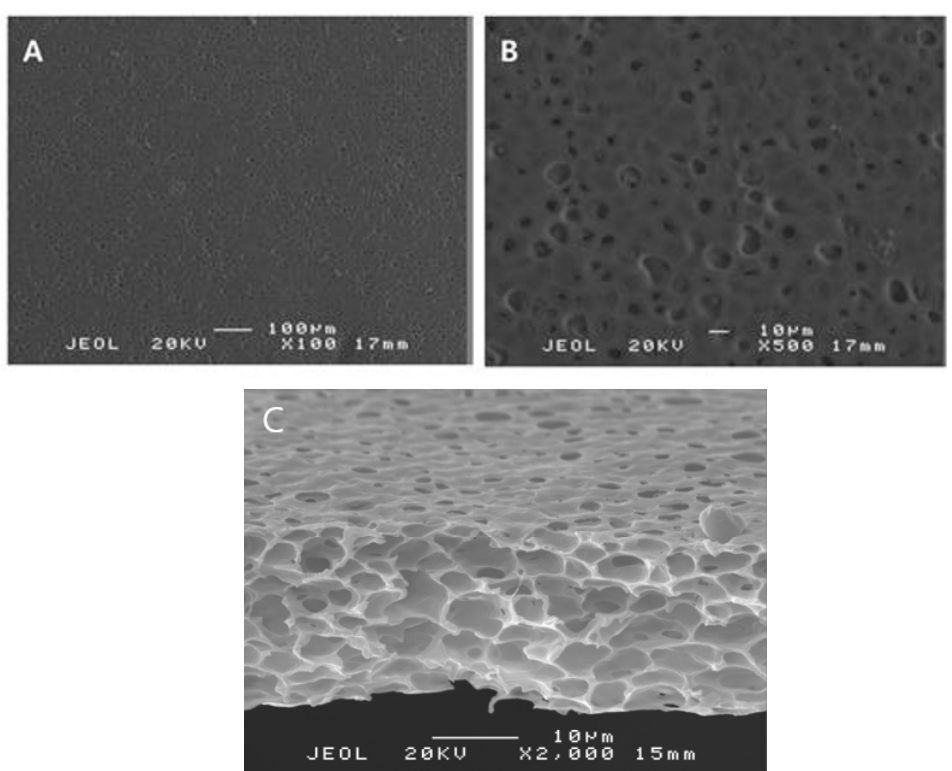
Figure 3. Scanning electron microscope image of a porous polylactide film. The thickness of film ranges from 10 to 20 µm. Note: Scale bar = 10 µm .